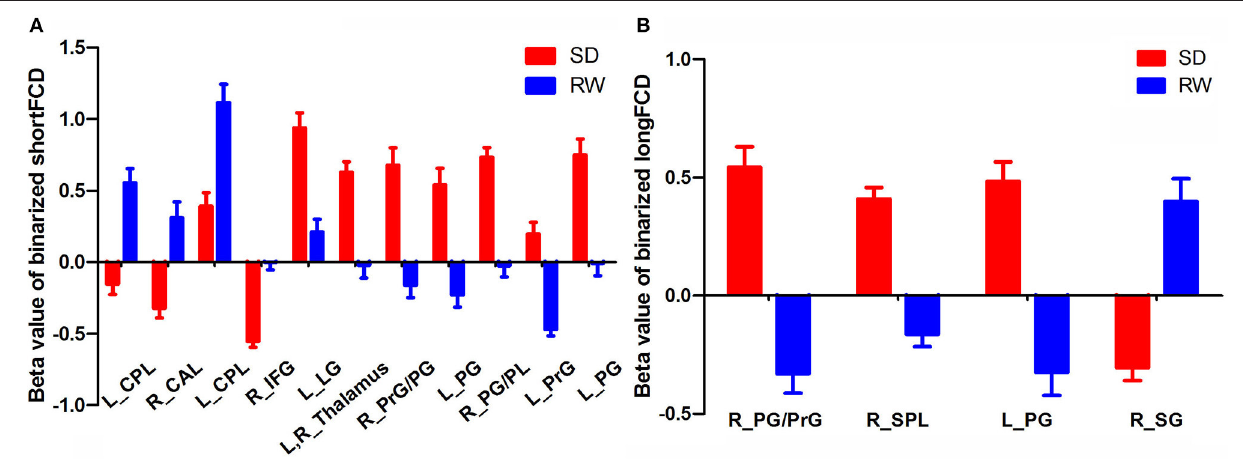
FIGURE 6 | Binarized shortFCD value (A) and longFCD value (B) of between-group differences in brain areas. Data are mean ± standard error values. L, left; R, right; shortFCD, short-range functional connectivity density; longFCD, long-range functional connectivity density; CPL, Cerebellum posterior lobe; CAL, Cerebellum anterior lobe; IFG, Inferior frontal gyrus; LG, Lingual gyrus; PrG, precentral gyrus; PG, Postcentral gyrus; PL, Paracentral lobule; SPL, Superior parietal lobule; SG, Supramarginal gyrus; SD, Sleep deprivation; RW, Rested